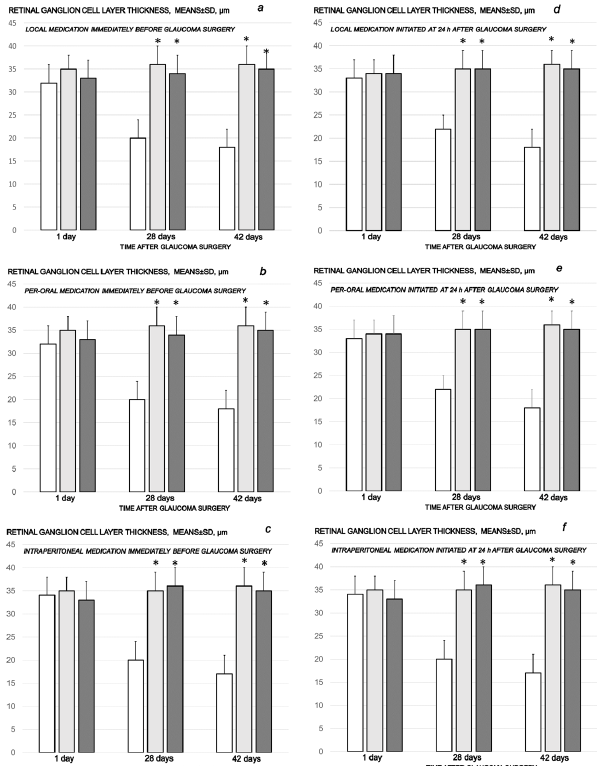
Figure 7. Cauterization of the three episcleral veins induced a decrease in retinal ganglion cell layer thickness, means ± SD, µ n, at the first post-operative day and at the end of the fourth and sixth post-injury week. Counteracting effect of BPC 157 medication daily regimen, prophylactic ( a – c ) or curative ( d – f ) (gray bars, light gray bars µ g-regimen, dark gray bars ng-regimen (0.4 µ g/eye, 0.4 ng/eye; 10 µ g/kg, 10 ng/kg) given locally as eye drops in each eye ( a , d ), intraperitoneally (last application at 24 h before sacrifice) ( b , e ) or per-orally in drinking water (0.16 µ g/mL, 0.16 ng/mL, 12 mL/rat until the sacrifice, first application given intragastrically) ( c , f )), started prophylactically (immediately before glaucoma surgery) or as curative treatment (at 24 h after glaucoma surgery). Controls (white bars) simultaneously received an equal volume of distilled water (two drops/eye), saline intraperitoneal application (5 mL/kg) or per-oral drinking water (12 mL/day/rat). A total of 6 rats/group/interval. * p < 0.05, at least, vs.